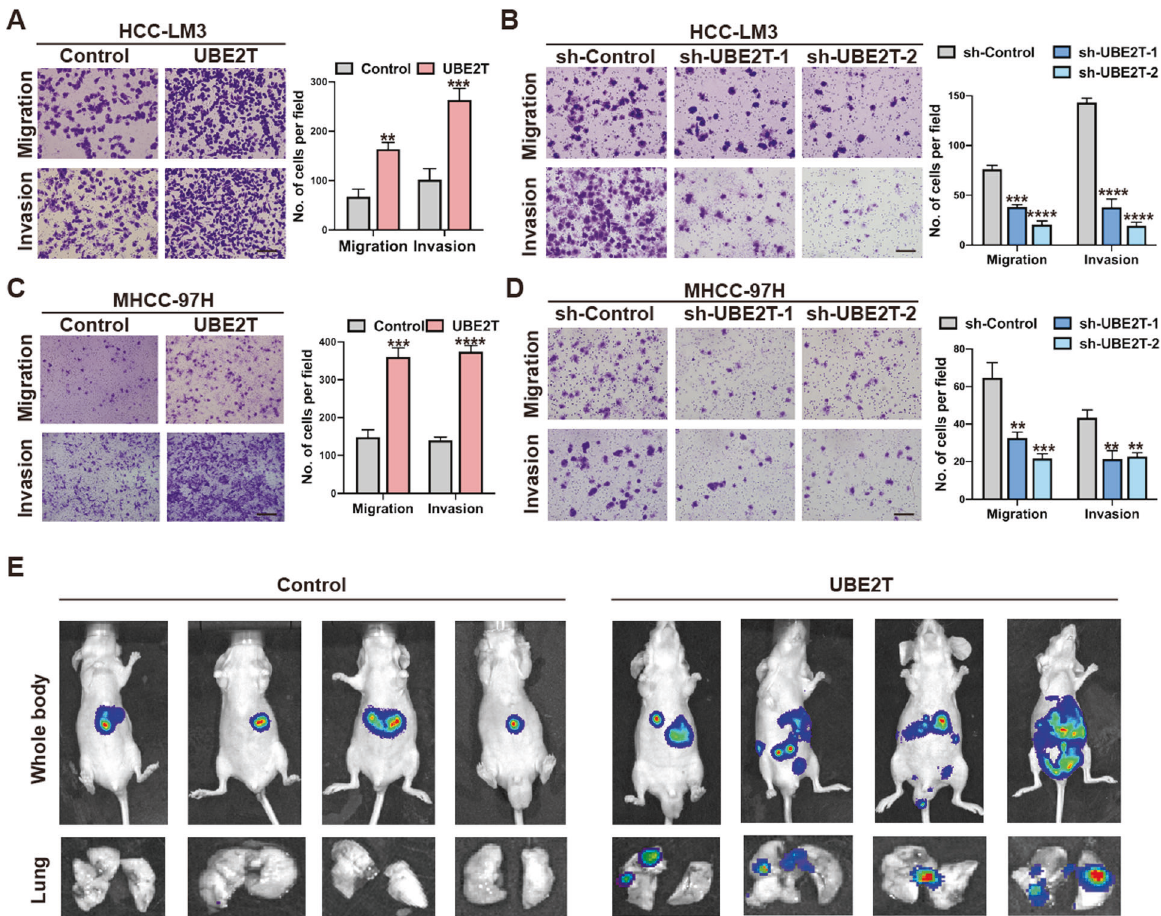
Fig. 2 UBE2T promotes HCC metastasis in vitro and in vivo. A – D Transwell assays to assess the migration and invasion ability of A UBE2T- overexpressing and control HCC-LM3 cells, B UBE2T-silencing and control HCC-LM3 cells, C UBE2T-overexpressing and control MHCC-97H cells, D UBE2T-silencing and control MHCC-97H cells. Quanti fi cations of cell number per fi elds are from at least three independent experiments. Error bar represent mean ± SD, * P < 0.05, ** P < 0.01, *** P < 0.001, **** P < 0.0001. Scale bar = 100 μ m. In A and C , a